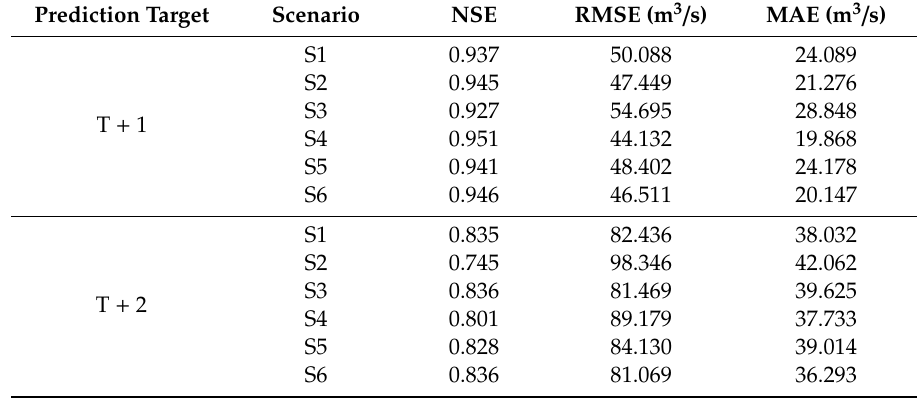
Table 6. The overall evaluation metrics of the validation and testing set for the best models in each